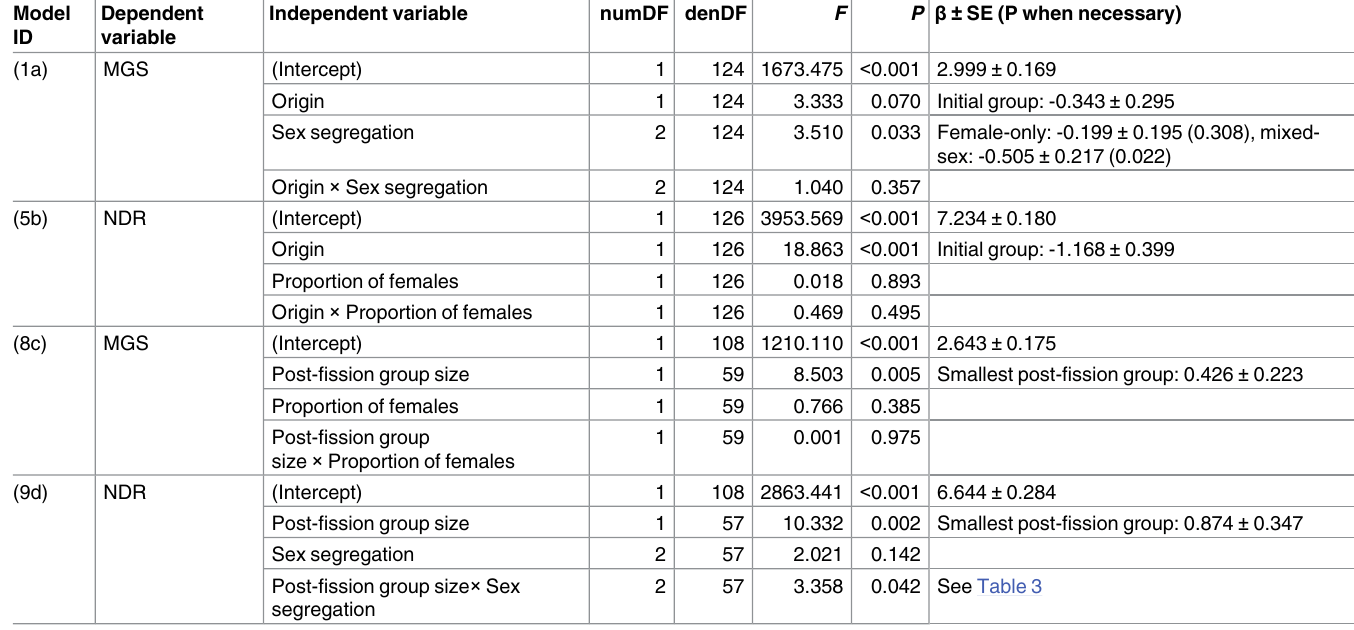
Table 2. Model statistics related to the effect of origin (initial vs . post-fission groups) and post-fission group size (smallest vs. largest post-fission groups) on the log-transformed mean group speed (MGS) and net displacement rate (NDR) using linear mixed-effects models including fission ID as a random effect (italicized classesare the referencegroups). Models controlled for group compositionindicatedby either sex segregation(mixed sex, female-only vs. male-only ),the proportionof adult males or females. Estimates with standard errors are presented when